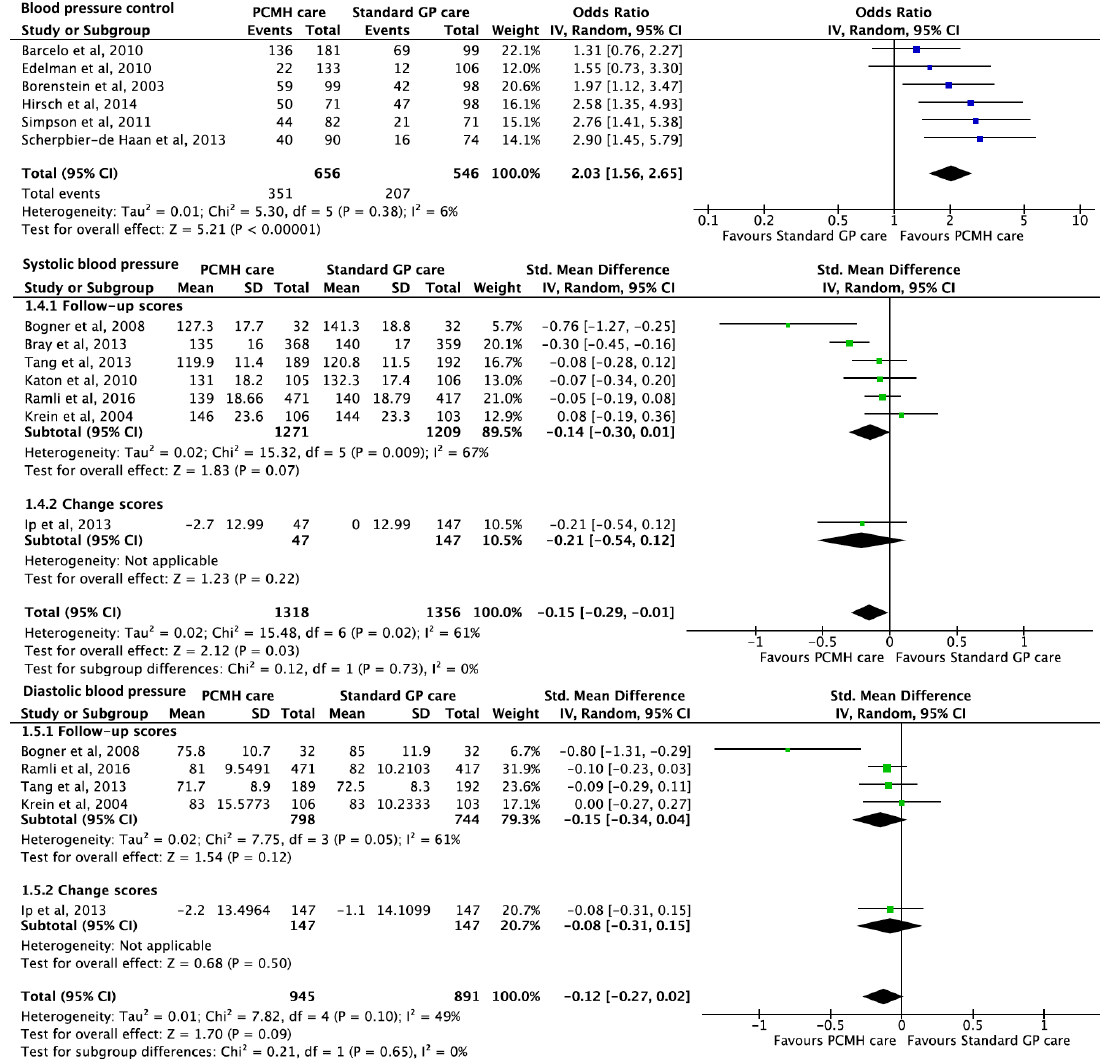
Figure 5. Forest plots of blood pressure outcomes between the PCMH care and Standard GP care. BP control refers to blood pressure levels within the guideline’s recommended range.